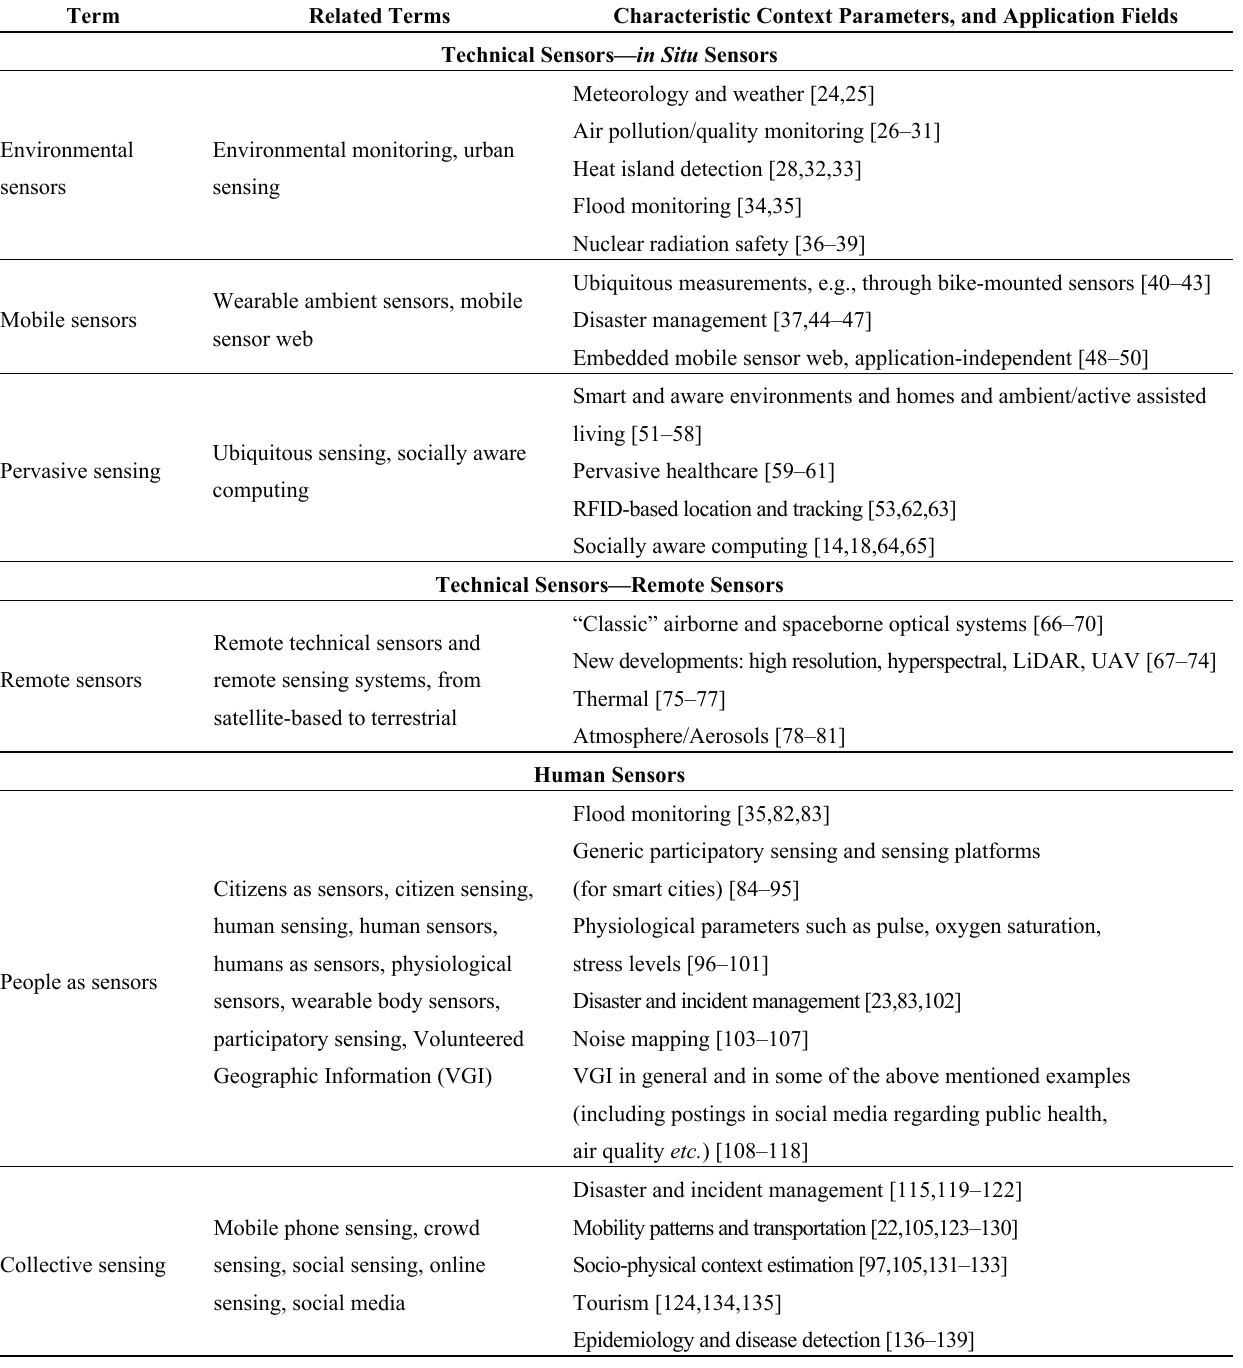
Table 1. Examples of sensors used for quantifying context to derive contextual information. Terms, related terms, characteristic context parameters, and application fields for different types of